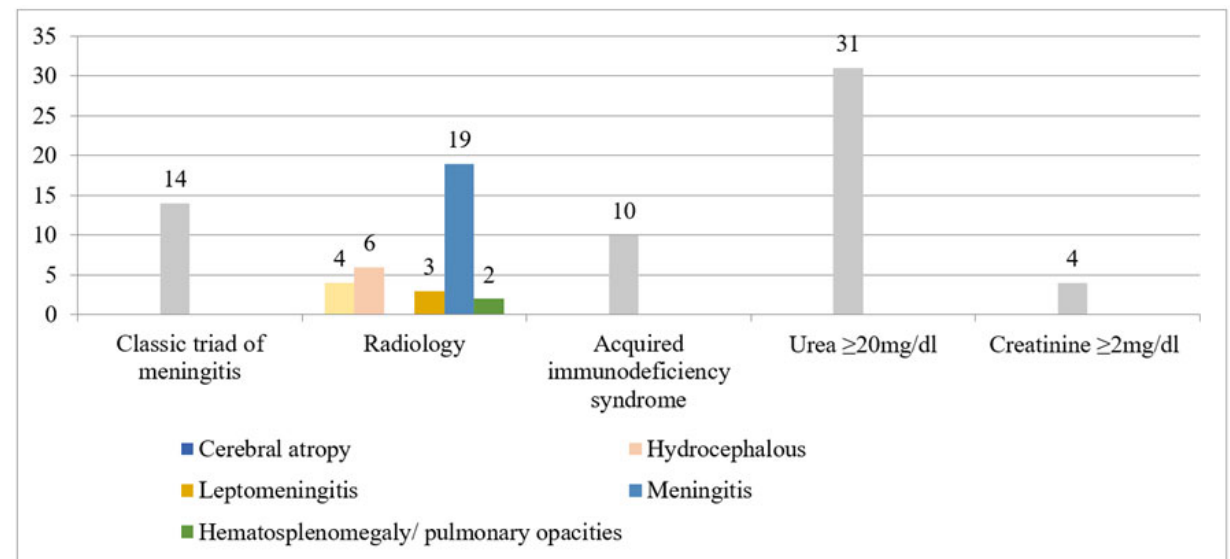
Figure 3. Clinical characteristics of Cryptococcosis.